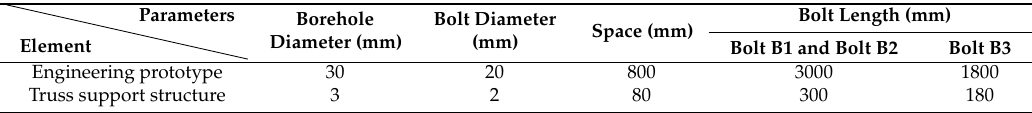
Table 3. Geometrical parameters of truss support structure.